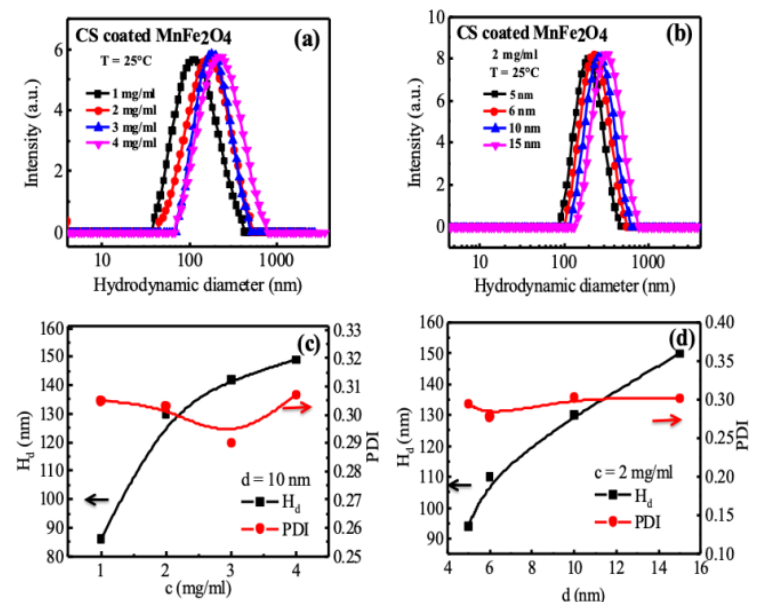
Figure 9. Hydrodynamic diameter (H d ) of CS-coated MnFe 2 O 4 nanoparticles measured at 25 °C. In the figure, we present ( a ) distribution of H d with concentration and ( b ) with nanoparticle size at 25 °C. Analyzing the data in ( a ) and ( b ), we presented ( c ) concentration and ( d ) nanoparticle size dependence of hydrodynamic diameter (H d ) and the polydispersity index (PDI).